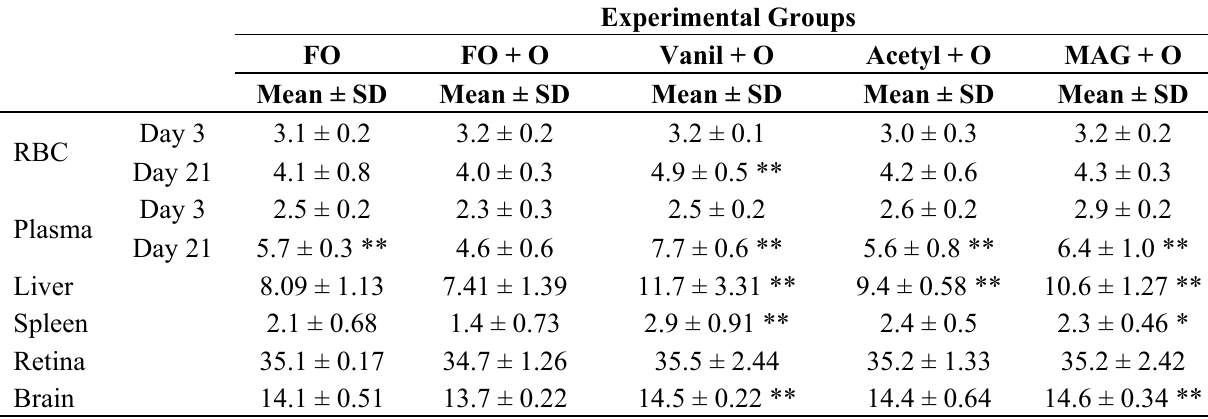
Table 4. Level of DHA (g/100 g fatty acids) in RBC, plasma, liver, spleen, retina and brain in